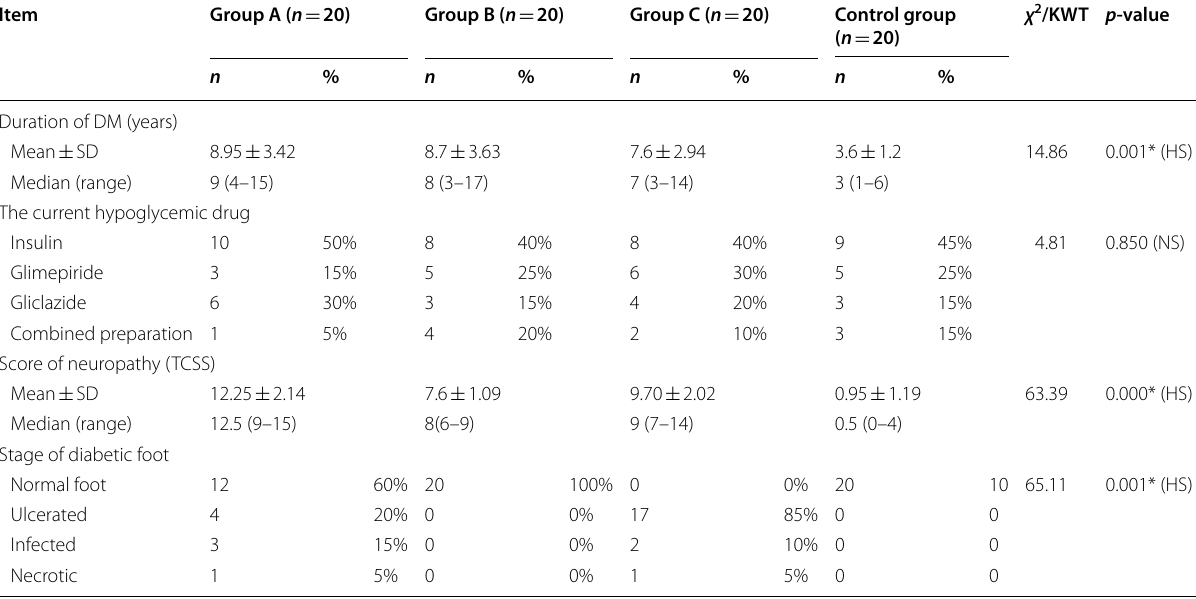
Table 2 Clinical characteristics of the studied